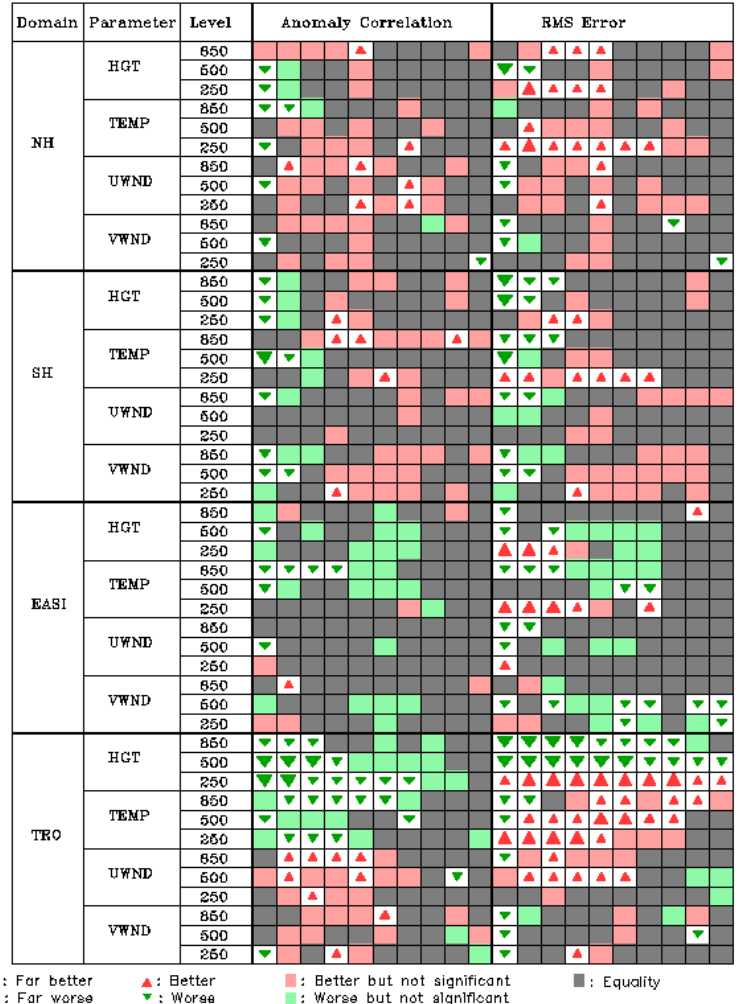
Figure 13. The same as Figure 10, but for the extended assimilation experiments in Table 4.